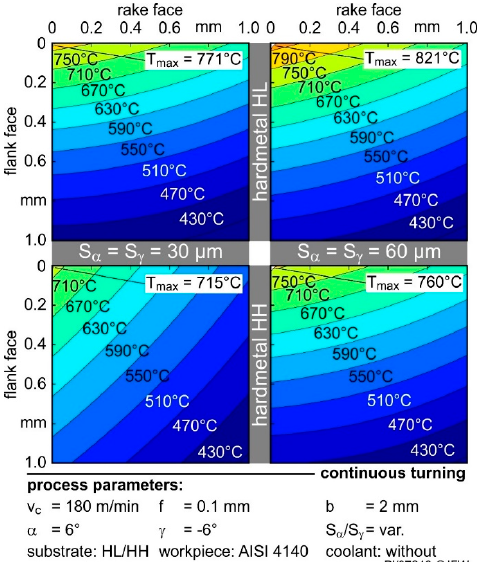
Figure 7. Influence of cutting edge roundings and cemented carbide thermal conductivity on the temperature distribution in cutting tools.